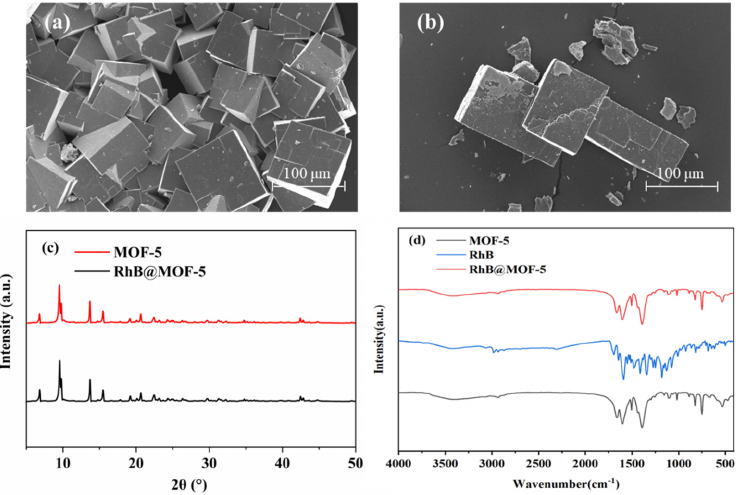
Figure 2. ( a ) SEM image of MOF-5; ( b ) SEM image of RhB@MOF-5; ( c ) PXRD patterns of MOF-5 and RhB@MOF-5; and ( d ) FT-IR spectra of MOF-5, RhB and RhB@MOF-5.